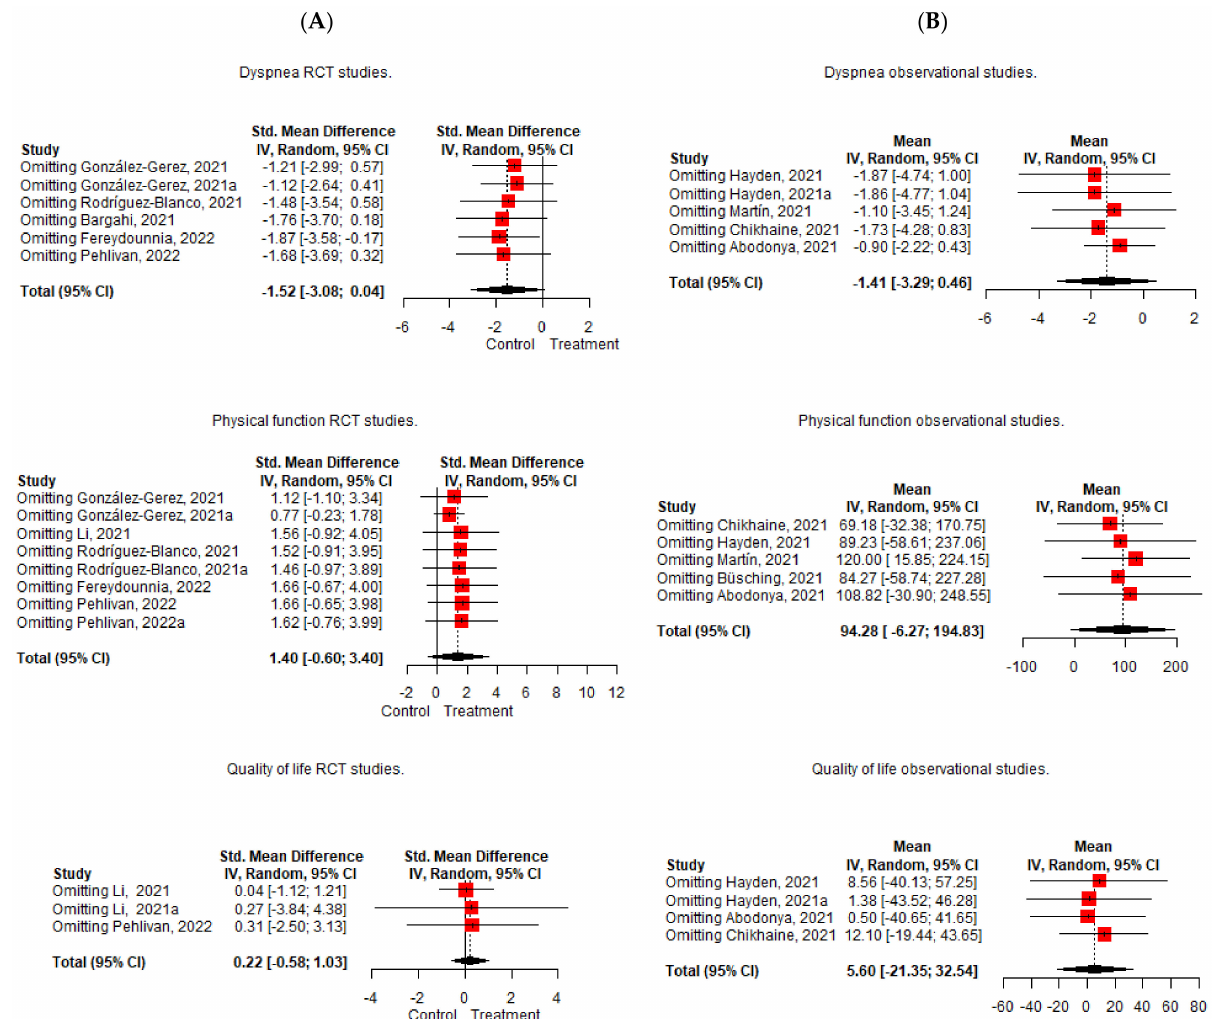
Figure 4. Leave-one-out analysis of the effect of Pulmonary Rehabilitation in post-acute patients with COVID-19 related to physical function, dyspnea, and quality of life. ( A ) RCTs assessed; ( B ) Observational studies